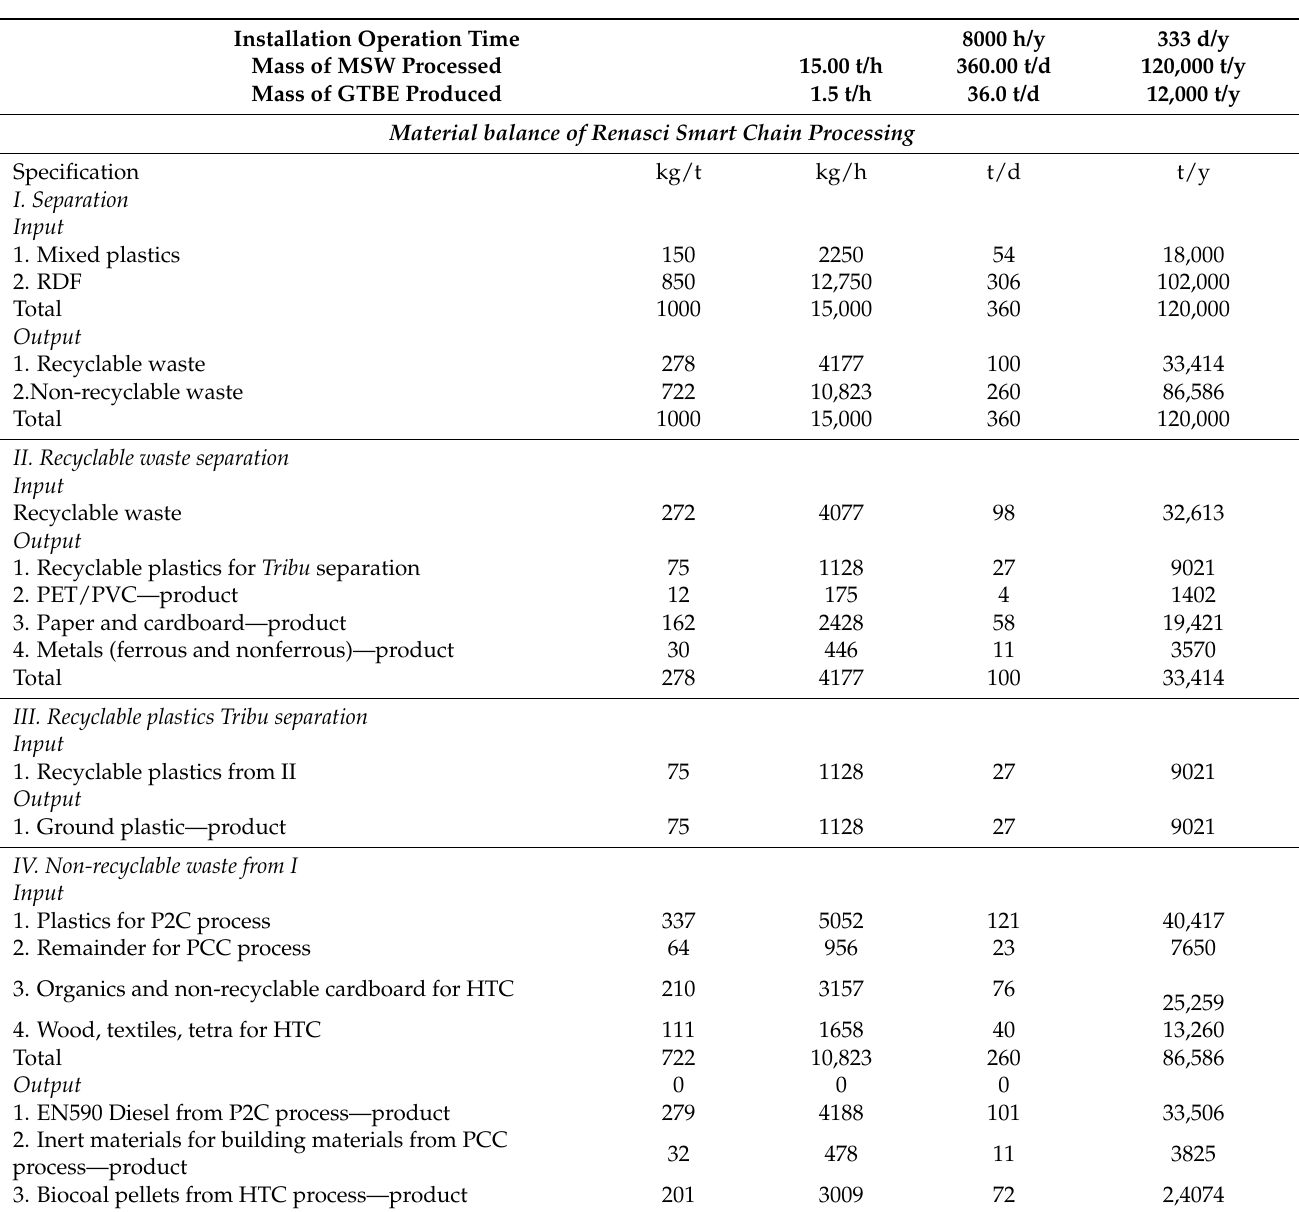
Table 2. Material balance—input/output analysis per ton of MSW using Renasci Smart Chain Processing and the BioRen-Renasci